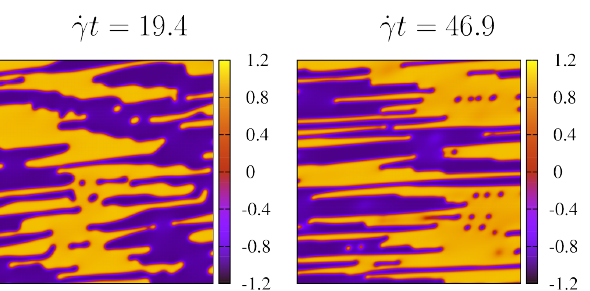
Figure 5. Configurations of the system in the weak ( left panel, ˙ γ t D = 0.4) and strong ( right panel, ˙ γ t D = 1.4) shear regimes with λ = 0. Snapshots are taken at the latest times of Figures 3 and 4. A central portion of size 512 × 512 of the whole lattice is